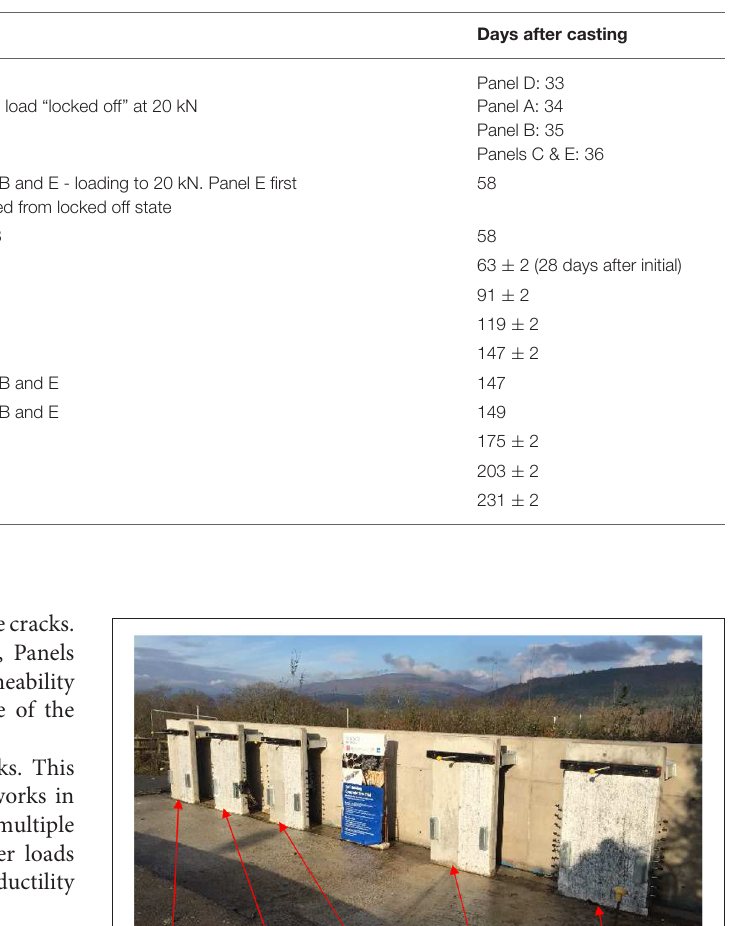
TABLE 3 | Site trial testing and monitoring schedule.